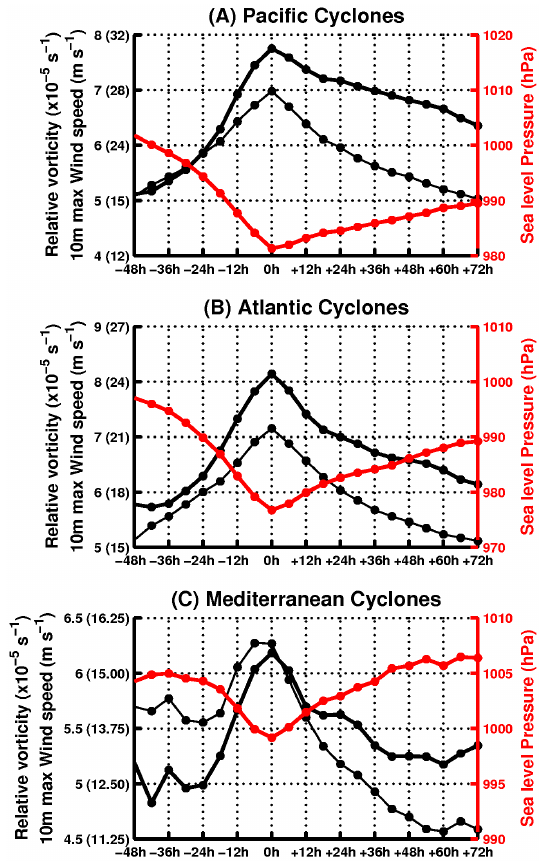
Figure 11. (a) Average composite time series of Pacific cyclones physical characteristics. “0h” corresponds to the time that the cy- clone presents its maximum relative vorticity. We denote relative vorticity (thick black line), sea level pressure (red thick line) and maximum 10m wind speed (thin black line). Wind speed scale val- ues are shown in the left vertical axes in parentheses. (b) As in (a) but for the Atlantic cyclones. (c) As in (a) but for Mediterranean cyclones. Note that y axis does not have the same value intervals across the three